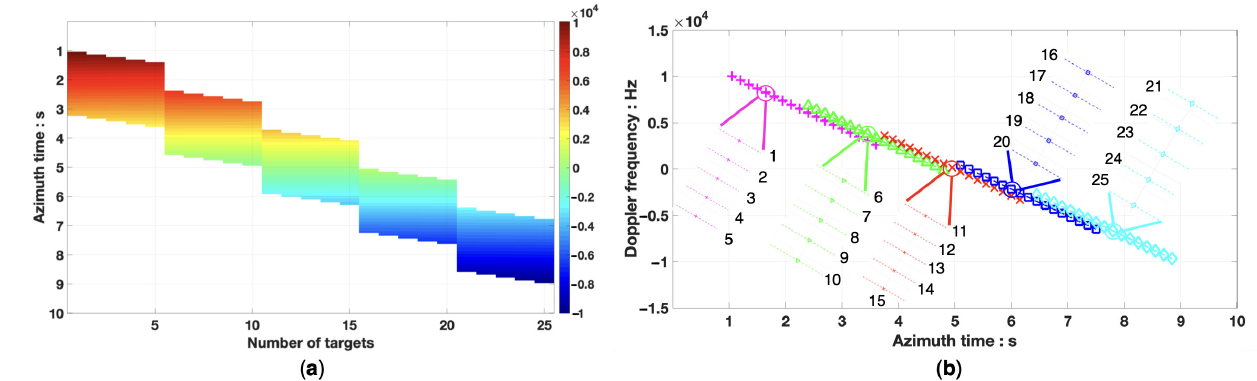
Figure 7. Doppler frequency changes with azimuth time of the targets. ( a ) The illuminated time of targets. ( b ) The relationship between Doppler frequency and azimuth time of targets. The pink cross, green triangle, red cross, blue square and light green diamond represent the time-frequency diagrams of targets 1–5, 6–10, 11–15, 16–20, and 21–25, respectively. The same color and shape mean the similar Doppler frequency